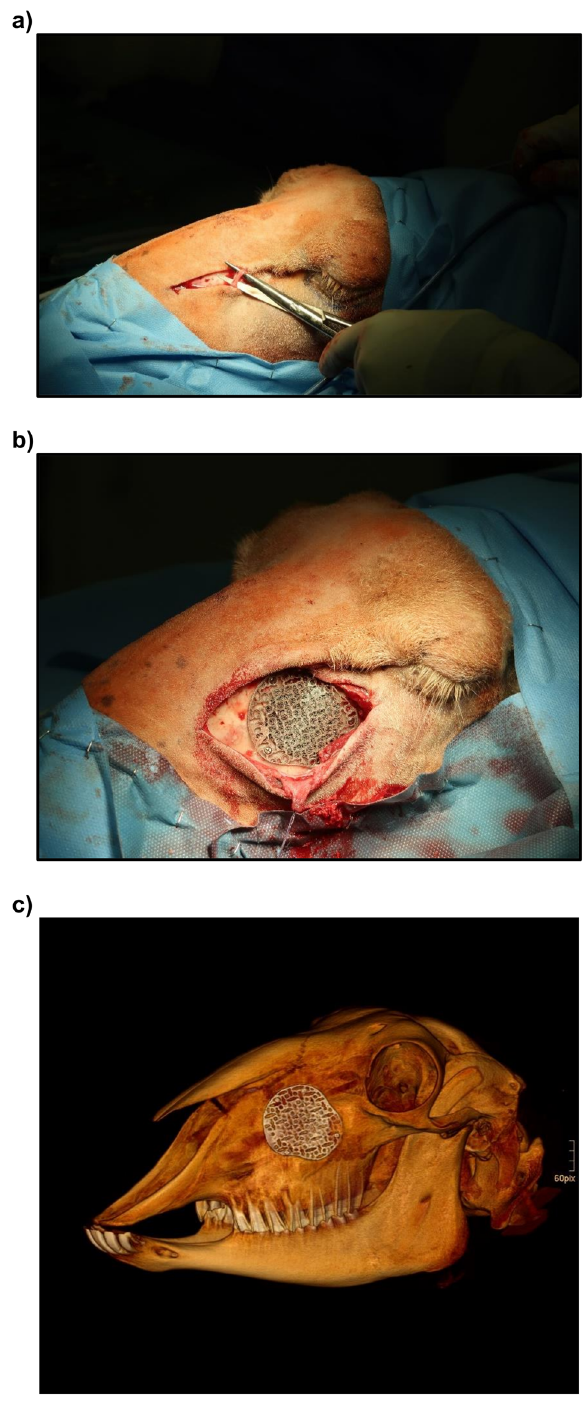
Fig. 3 a , b Intraoperative exemplary image after preparation of the angular vein and insertion of an empty scaffold into a 2.4 cm defect in the anterior wall of the maxillary sinus. c Postoperative CT scan showing correct placement of the